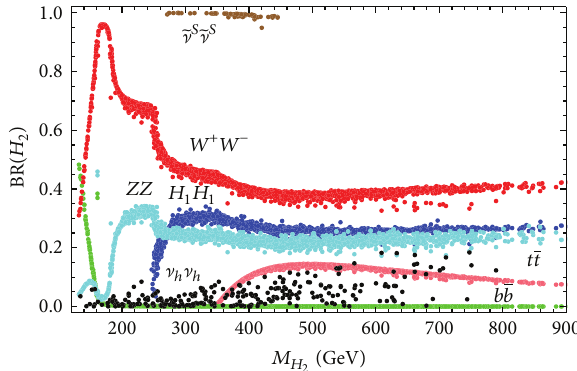
> 𝑀 = 125 GeV. The 𝐻 1 2